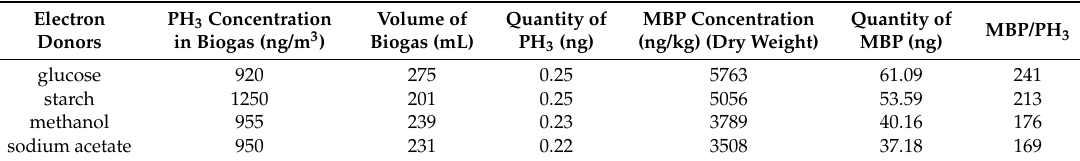
Table 2. The production of PH 3 and MBP.